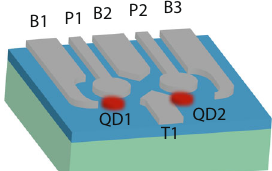
Fig. 1 A prototype double quantum dot in a 2D hole gas. The red shaded circles represent two quantum dots con fi ned by a set of gates. Our focus is on a single dot; two dots are shown to illustrate scaling up strategies, e.g., gates B 2 and T 1 control inter-dot